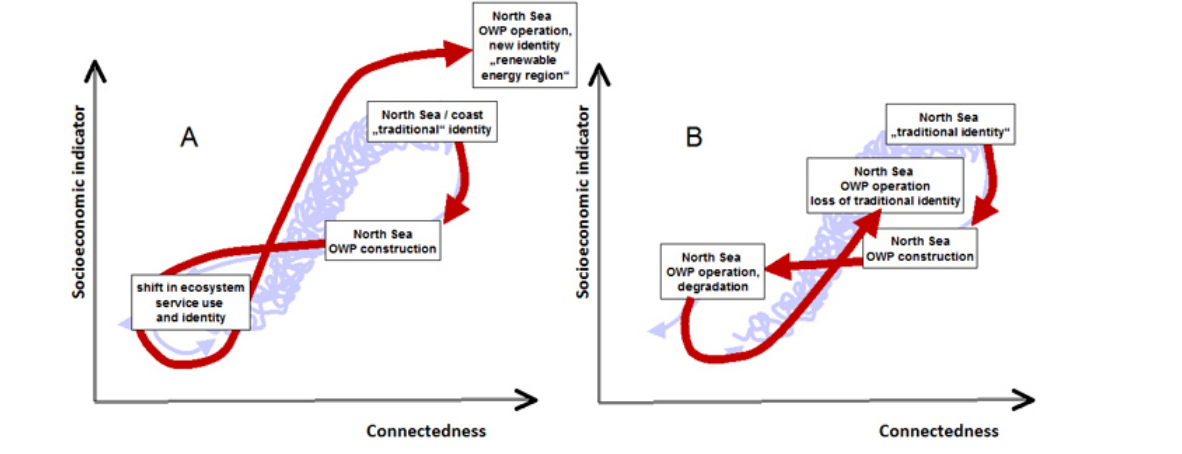
Fig. 6 . Offshore wind farming (OWF) in the German North Sea; potential socioeconomic system trajectories: A) development of a renewable energy region; and B) loss of traditional